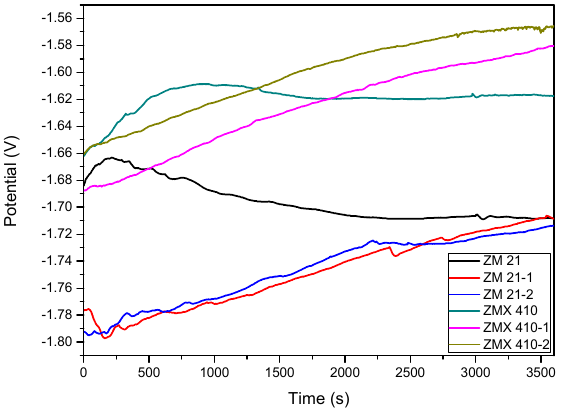
Figure 14. The Tafel curves of all samples tested in SBF.